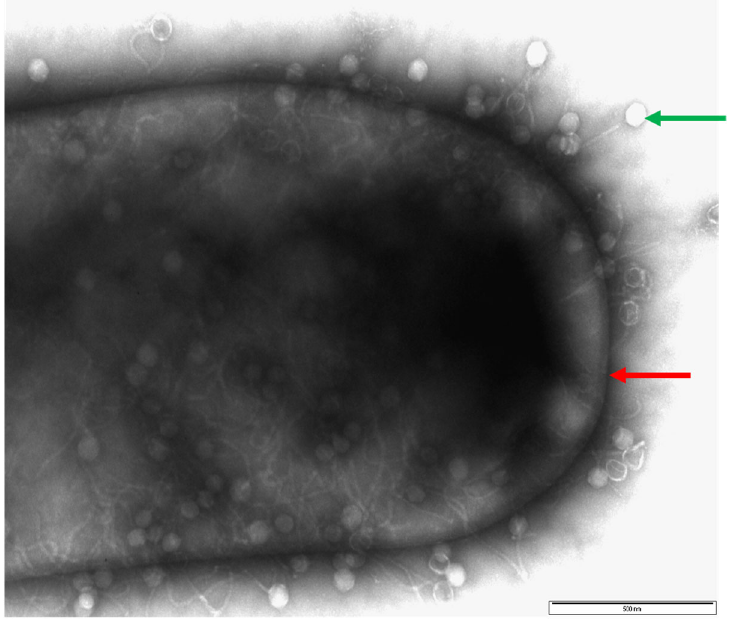
Figure 2. Image of a CD105LC1 C. difficile cell (red arrow) surrounded by phage phiCDHS1 (green arrow), which have attached to the surface of the bacterial cell wall. Exponentially growing bacteria cultures were mixed with phage at a ratio of 1:100 (bacteria to phage ratio) and allowed to attach for 15 min. Afterward, the phage/bacterial cultures were fixed with 2% glutaraldehyde and mounted on glow ‐ discharged pioloform/carbon ‐ coated copper grids for 5 min. After being washed with water, samples were stained with uranyl acetate, air ‐ dried and examined using a JEOL 1220 electron microscope at 80kV voltage. Bar is approximately 500 nm.